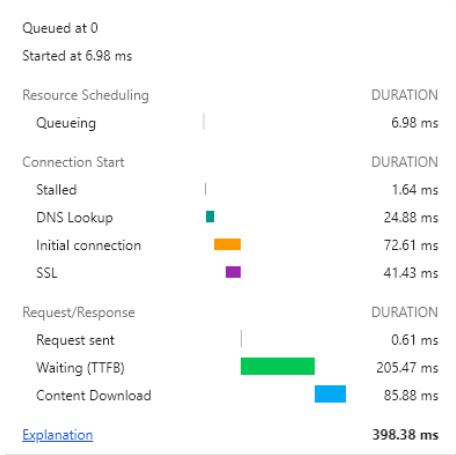
Figure 5. Preview of an indicative timing breakdown in